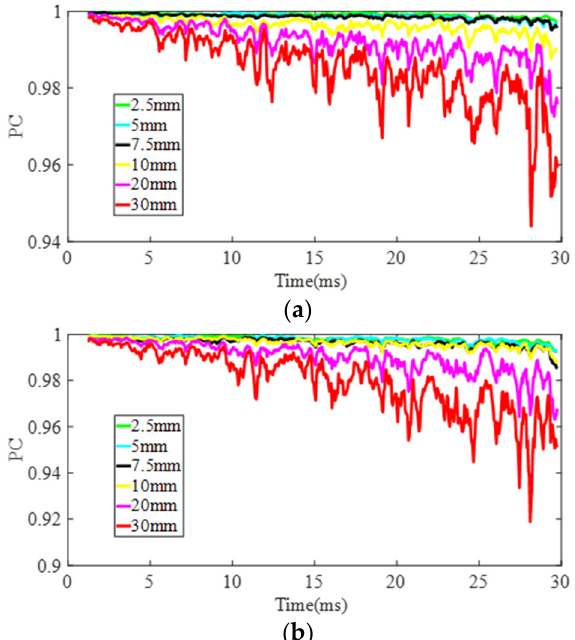
Figure 16. Peak coherence in each condition: ( a ) damage is located at the middle point of the direct sensing path and ( b ) damage is located at the left point of the direct sensing path.